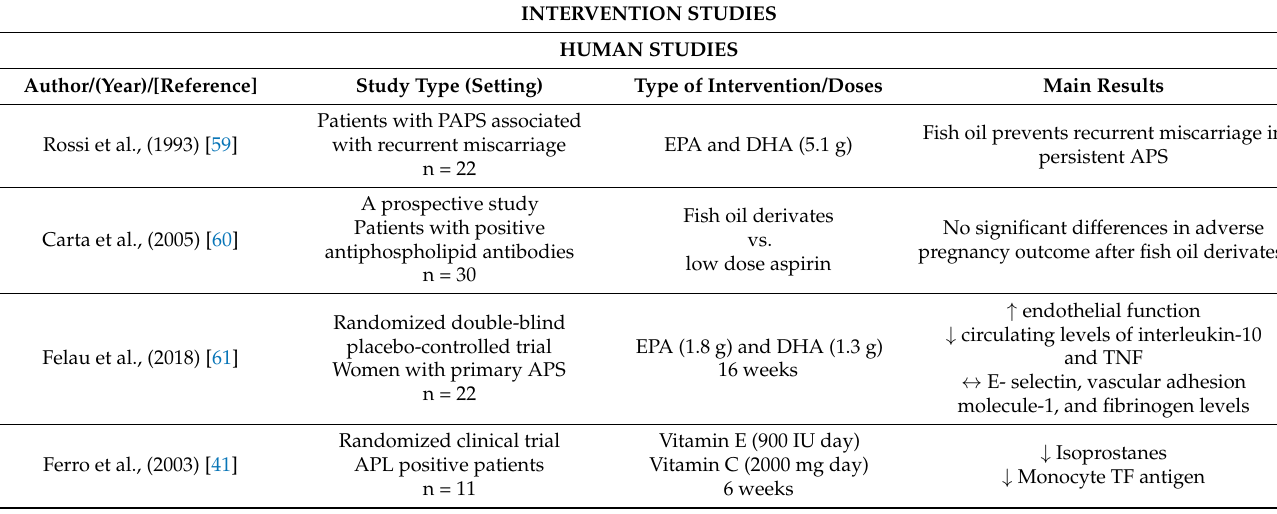
Table 2. Main characteristics and main results of supplementation studies with antioxidants in patients with APS, experi- mental model of APS and in vitro